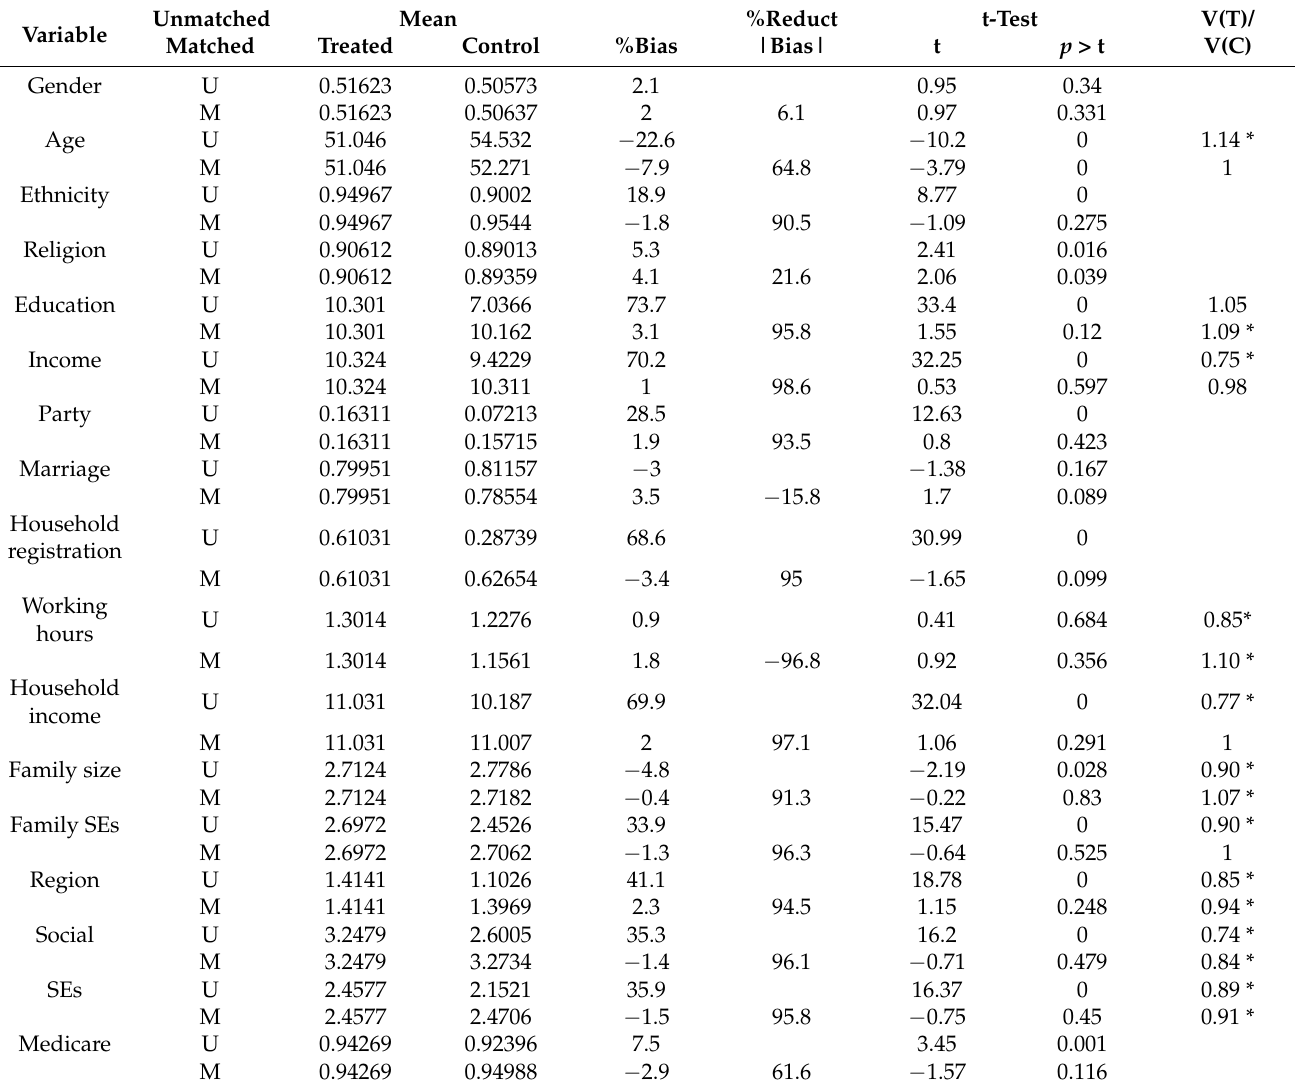
Table 4. Comparison of experimental and control groups after PSM.